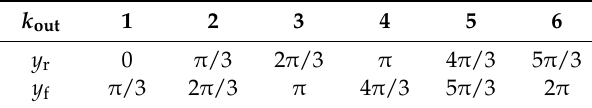
Table 4. Value of y r and y f when k out change from 1 to 6.